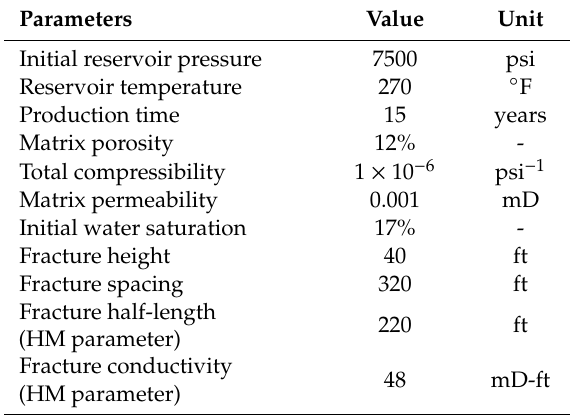
Table 1. Properties of reservoir and fracture from the Eagle Ford formation.